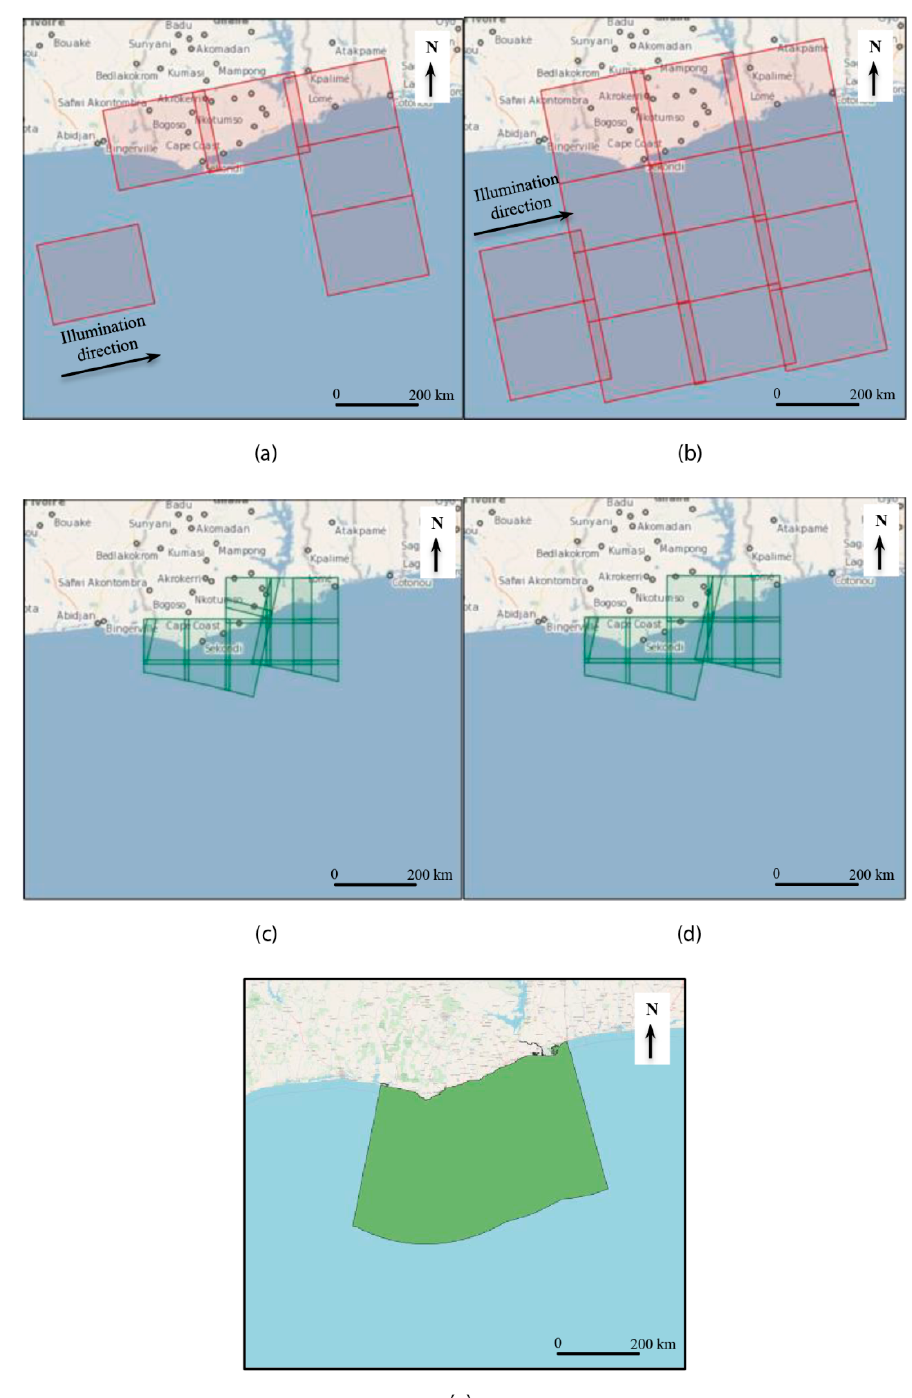
Figure 2. Available scenes for the coast of Ghana for the period spanning 01 November to 12 November 2017 (spanning 1 complete revisit cycle) for ( a ) Sentinel-1A, ( b ) Sentinel-1B, ( c ) Sentinel-2A, and ( d ) Sentinel-2B. The pass times for Sentinel-1A and Sentinel-1B are 18:10 and 18:20 GMT. For Sentinel-2 the pass times are at 10:20 and 10:30. Ghana exclusive economic zone (EEZ) is shown in ( e ).